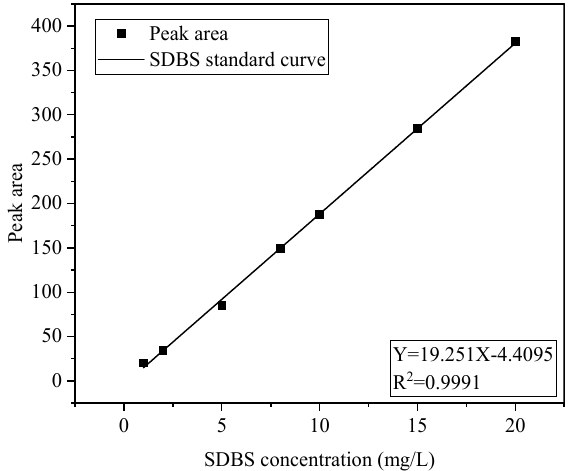
Figure 1. Standard curve of SDBS concentration.